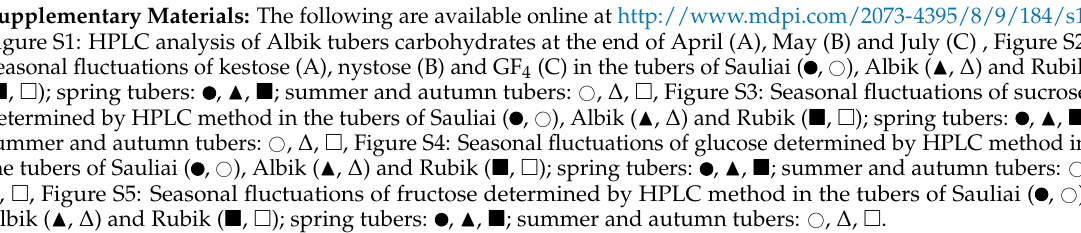
Figure S1: HPLC analysis of Albik tubers carbohydrates at the end of April (A), May (B) and July (C) , Figure